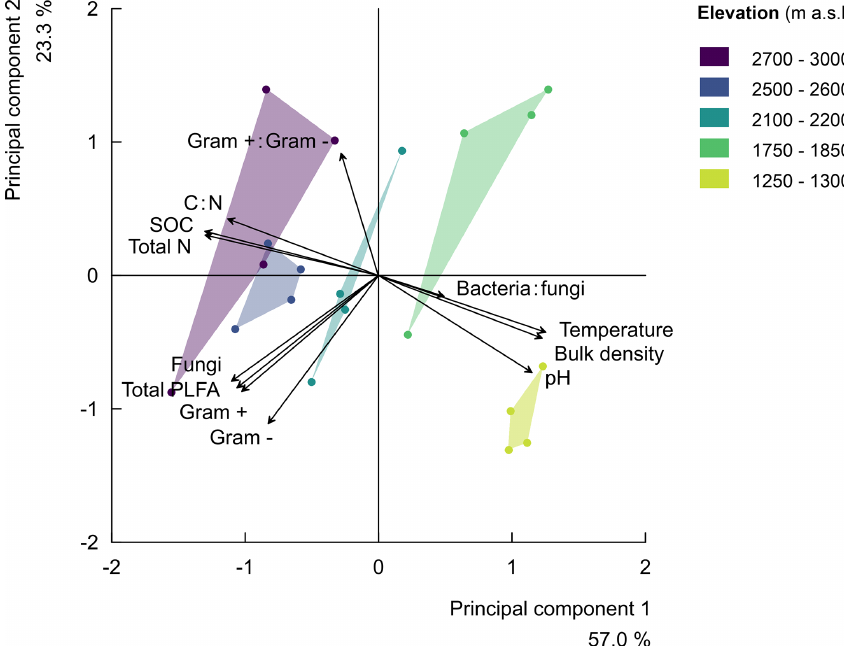
Figure 2. Principal component analysis (rescaled) of the relationships along the elevation gradient for soil physicochemical properties (i.e. the soil total nitrogen (total N), soil organic carbon (SOC), carbon-to-nitrogen ratio (C : N), soil pH (pH), soil temperature at 5cm depth (temperature), and bulk density) and the microbial community compositions (i.e. the bacteria-to-fungi ratio, bacteria : fungi, total PLFA in nmolg − 1 of soil, and the ratio of gram-positive-to-gram-negative bacteria, gram+ : gram-). The principal component 1 explained 57.0% of the variability in the studied parameters, while principal component 2 explained 23.3% of the variability. The symbols of the individual plots on the biplot of the first two principal components are shown in different colours per elevation